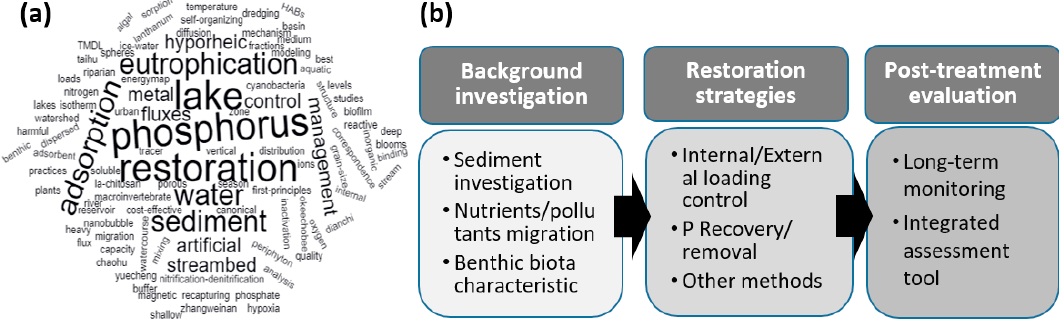
Figure 3. Distribution of keywords used in the 12 papers in the Special Issue ( a ), and the summarised procedure for research into (and applications in) lake and river restoration ( b ).